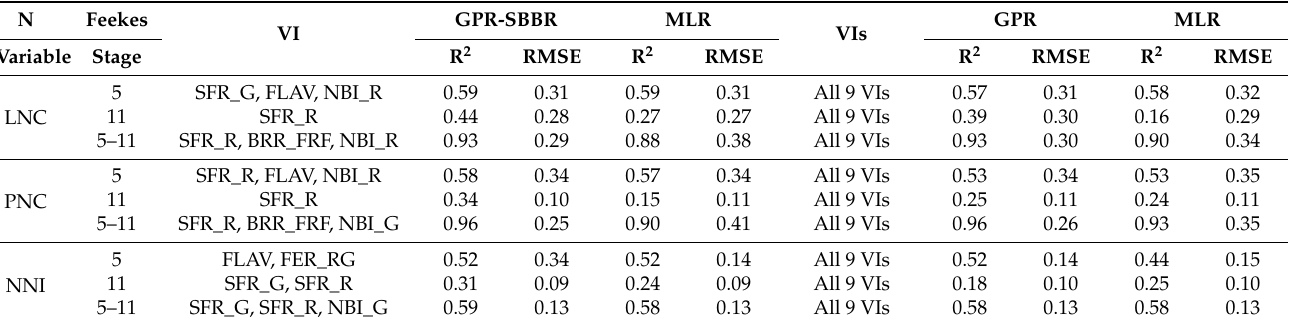
Table 10. Cross-validation results for N estimation through GPR and MLR methods based on Multiplex VIs.